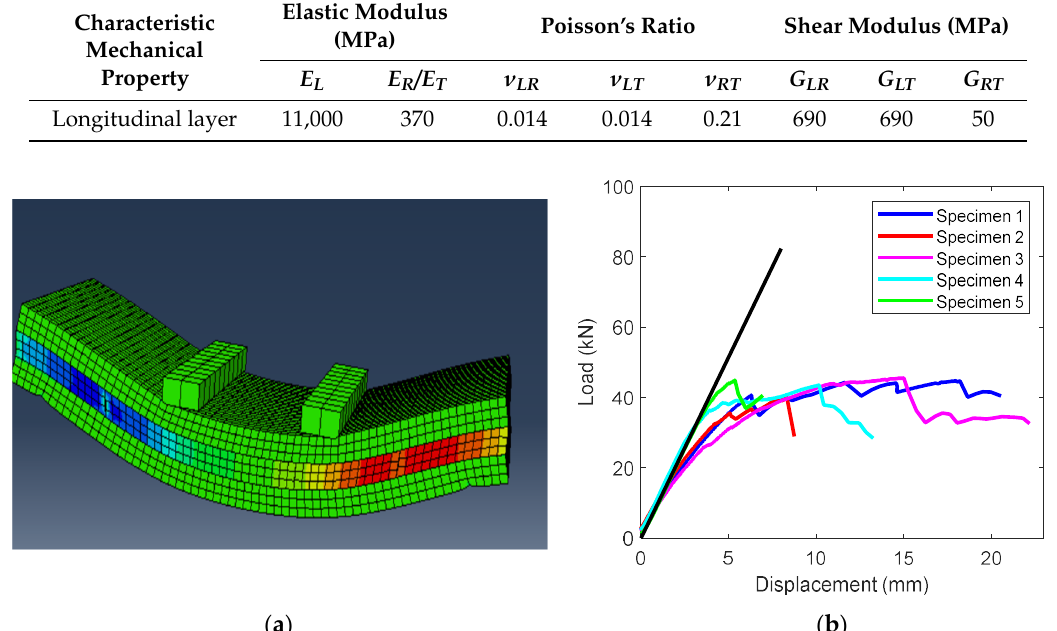
Figure 5. The ( a ) FE model with rolling shear stress (shear stress radial–tangential plane) profile and ( b ) load-displacement results from the experimental tests and FE model.